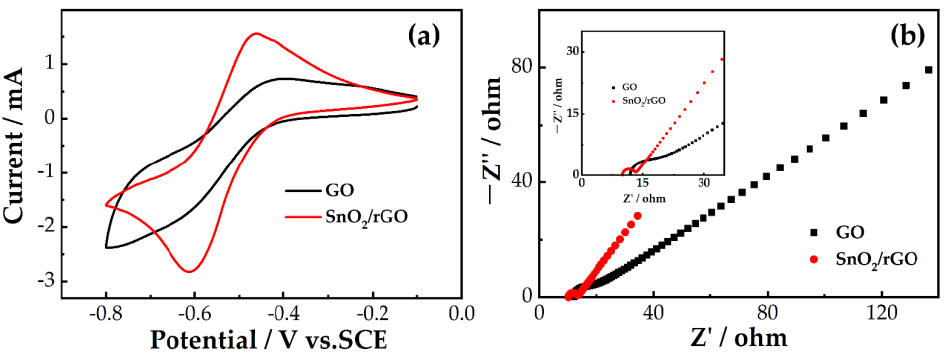
Figure 6. ( a ) CV curves; ( b ) CV curves at the scan rate of 10 mV s − 1 and Nyquist plots for GO and SnO 2 /rGO in 1.6 M V 3+ + 3.0 M H 2 SO 4 electrolyte.